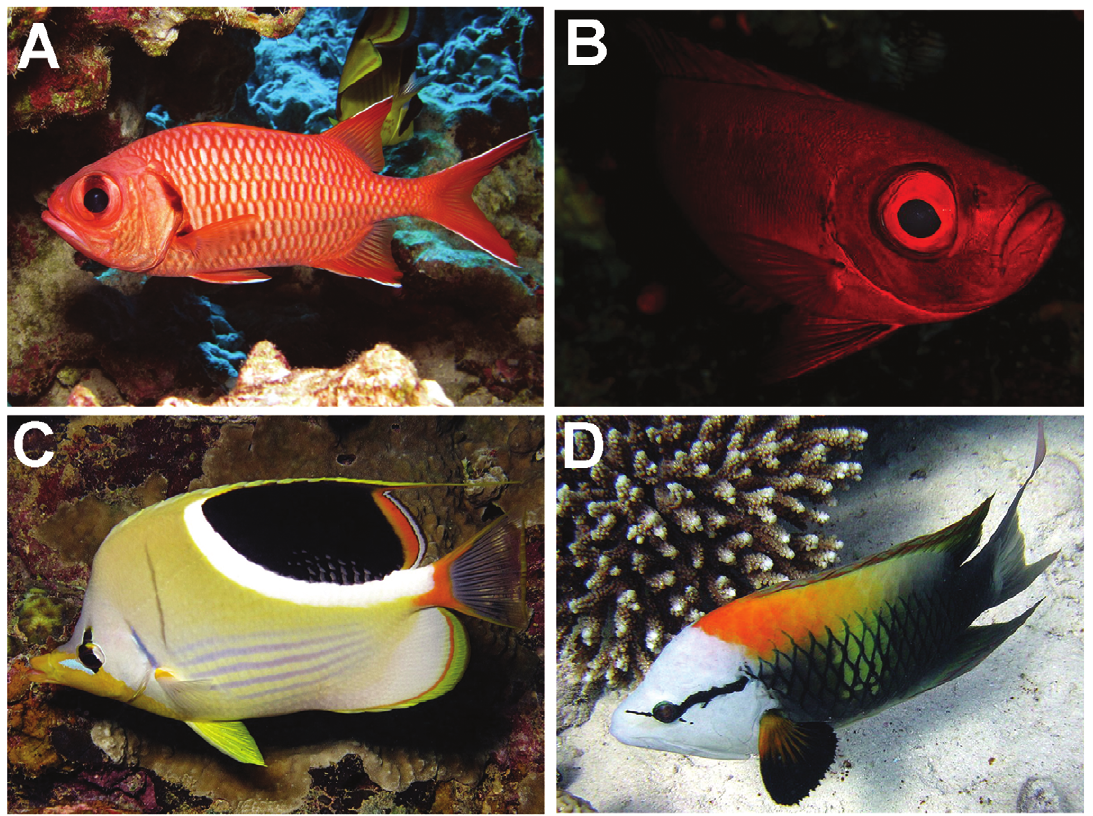
Figure 3. Examples of two species of nocturnal reef fish surveyed in this study: Myripristisberndti (A) and Priacanthushamrur (B). The large eye to body length ratios of these two species ( M. berndti : 0.15; P. hamrur : 0.11) give evidence of their nocturnal lifestyle. Like many nocturnal fish, M. berndti and P. hamrur both dramatically increased in abundance at Tabuaeran where large daytime active predators were less abundant. Example diurnal fish Chlorurus sordidus (C) and Epibulus insidiator (D) exhibit the smaller eye to body length ratios ( C. sordidus : 0.05; E. insidiator : 0.05) that are more characteristic of diurnal reef fish. These species were among the diurnal prey fish taxa whose abundance showed negative or weak responses to predator depletion.